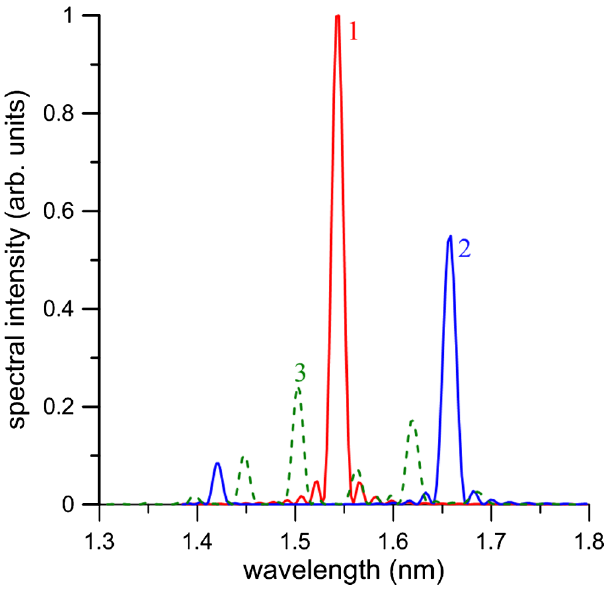
FIG. 3. Radiated spectra of sample electrons ( K ¼ 0 : 4 ): 1—spectrum produced by a counterpropagating wave only ( R ¼ 4 : 9 mm , (cid:10) ¼ 8 : 3 (cid:7) 10 (cid:5) 2 ); 2—spectrum produced by copropagating and counterpropagating waves together ( R ¼ 4 : 9 mm , (cid:10) ¼ 8 : 3 (cid:7) 10 (cid:5) 2 ); and 3—spectrum produced by copropagating and counterpropagating waves together ( R ¼ 9 : 6 mm , (cid:10) ¼ 1 : 9 (cid:7) 10 (cid:5) 2